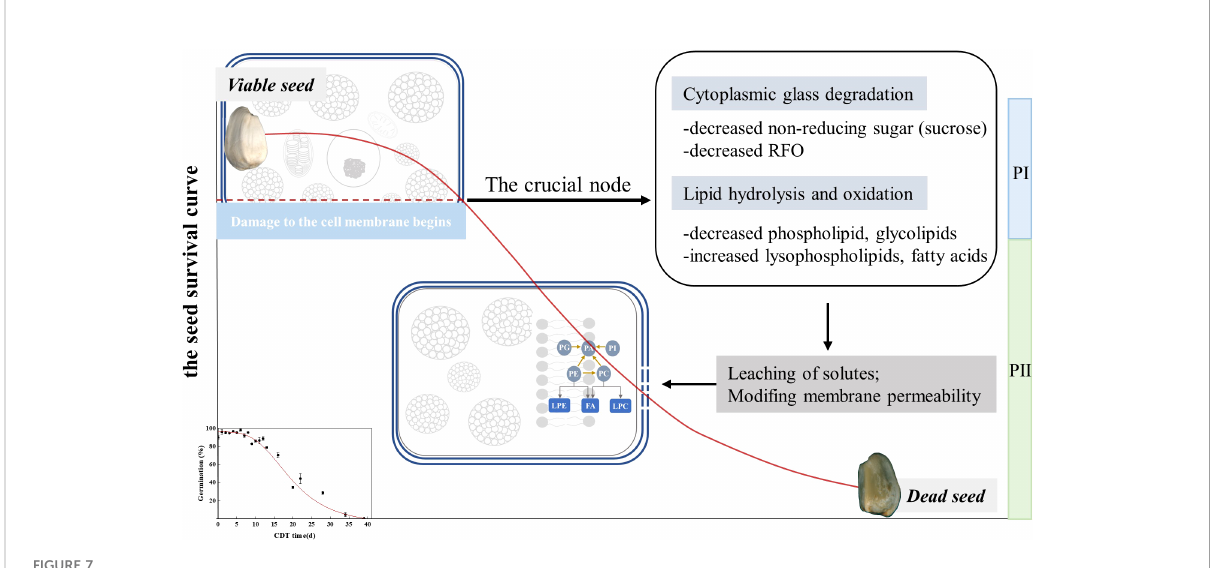
FIGURE 7 Schematic diagram of the proposed model showing the seed survival curve of an enlarged version of saf fl ower. The seeds gradually lost their vigor with increasing aging time. In the PI phase, seed lipids and carbohydrates undergo energy metabolism. At the CN, the direct energy substance, sugar, is low, and structural lipids are hydrolyzed and oxidized. The structure of the seed cell membrane begins to be destroyed, which brings irreversible damage to the seed vigor. During the PII period, a large amount of lipid hydrolysates accumulated and could not be metabolized, resulting in delayed seed germination and inhibition of seedling formation. Aging eventually made seeds unable to